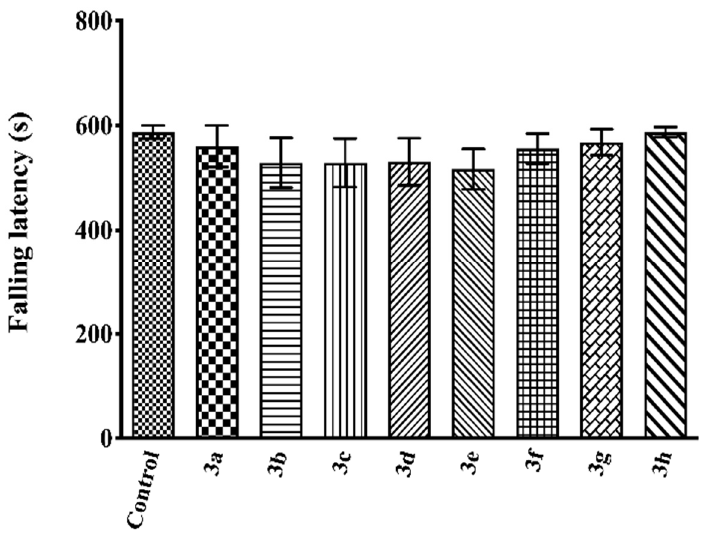
Figure 6. Effects of test compounds 3a – 3h (50 mg/kg) on falling latencies of mice in the Rota-Rod